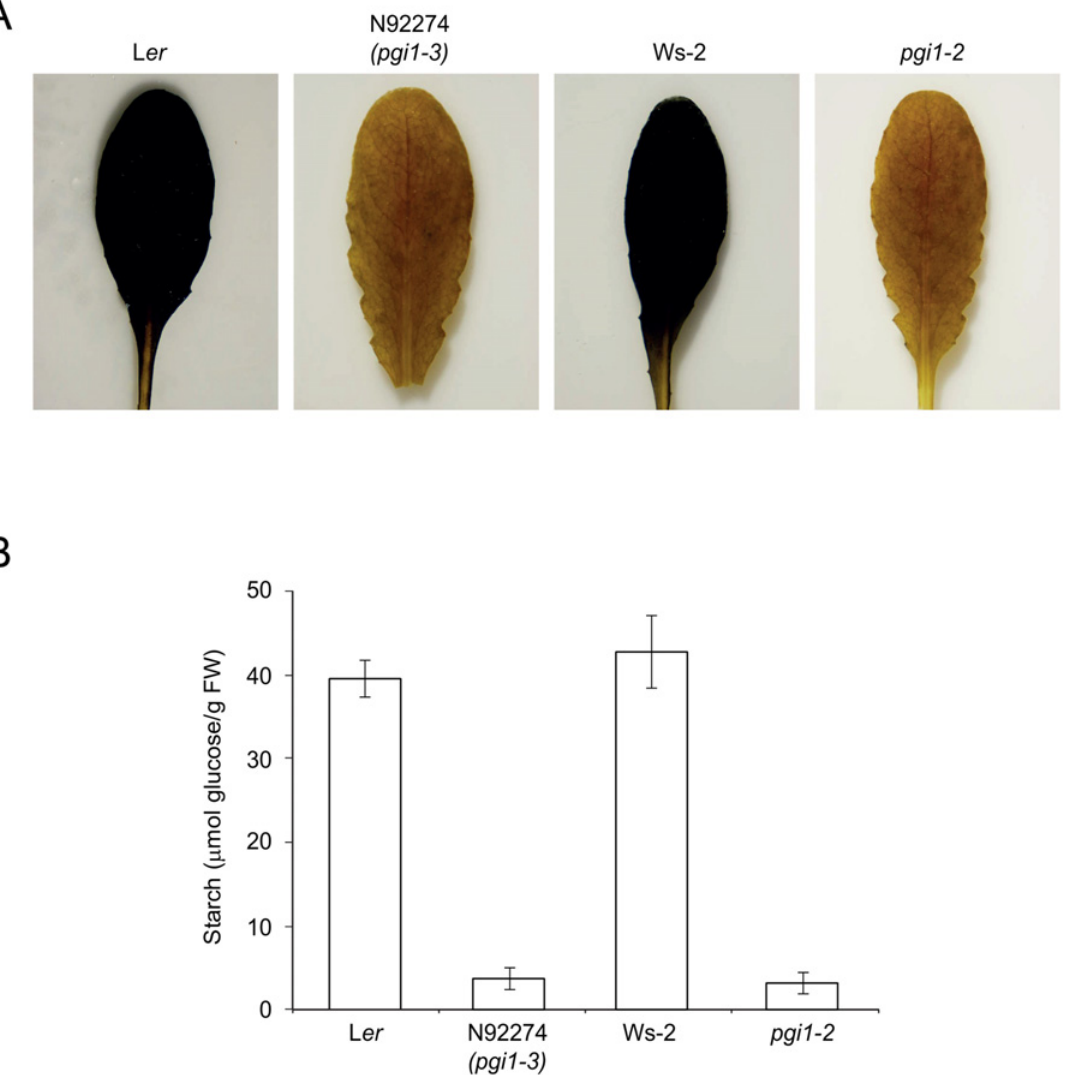
Fig 2. Leaves of the pgi1 – 3 mutant accumulate low starch. (A) Iodine staining and (B) starch content of L er , pgi1 – 3 , Ws-2 and pgi1 – 2 leaves. Plants were cultured on soil under LD conditions and source leaves harvested from 30 DAG plants after 12 h of illumination. In “ B ” values represent the mean ± SE of determinations on five independent